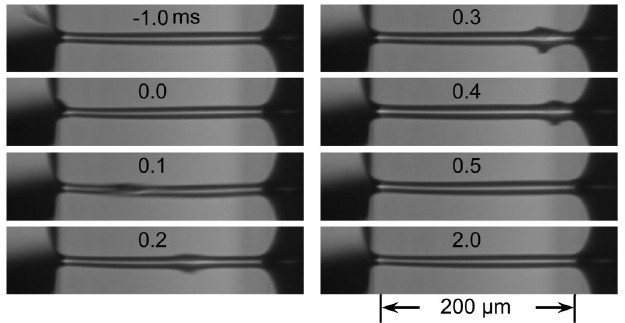
FIG. 8. The passage of a piece of debris twice the size of the equilibrium jet diameter. The bridging jet of 14 (cid:1) m diameter self-adjusted to pass the 30 (cid:1) m -long piece of debris, and relaxed back to its equilibrium configuration within 2 ms. The snapshots were captured from Video 5